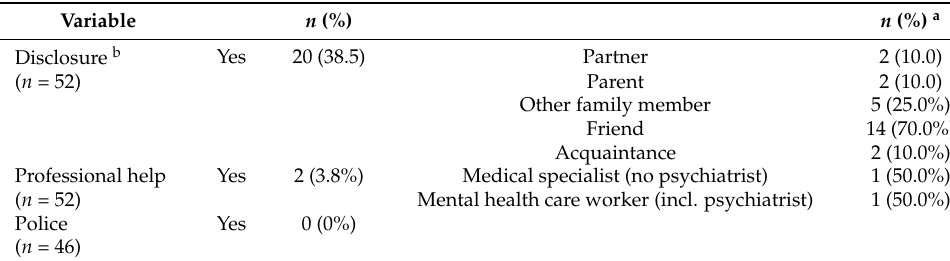
Table 7. Disclosure and help-seeking after sexual victimization.